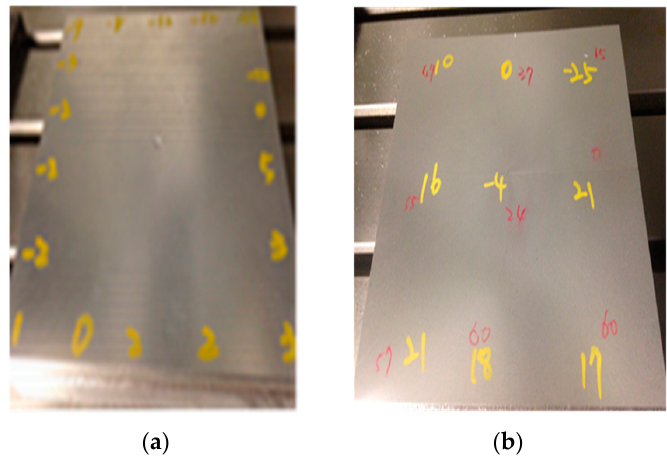
Figure 14. Machined surface ( a ) without compensation ( b ) with